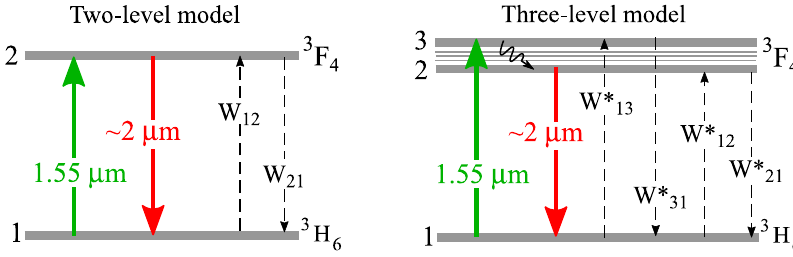
expression for three-level model n 1 + n 2 +n 3 = 1 reduces to n 1 + n 2 = 1, which coincides with Equation (1).